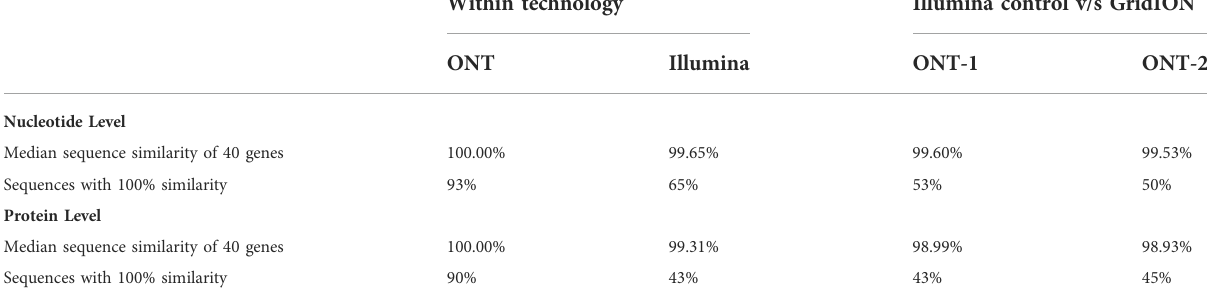
GridION test samples ONT-1 and ONT-2, when compared against Illumina control, showed median sequence similarities of 99.60% and 99.53% at nucleotide level and 98.99% and 98.93% at protein level respectively.